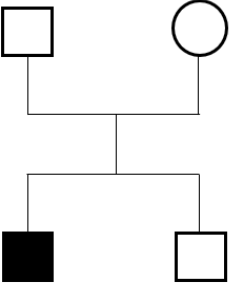
Figure 2. Pedigree of the index case.